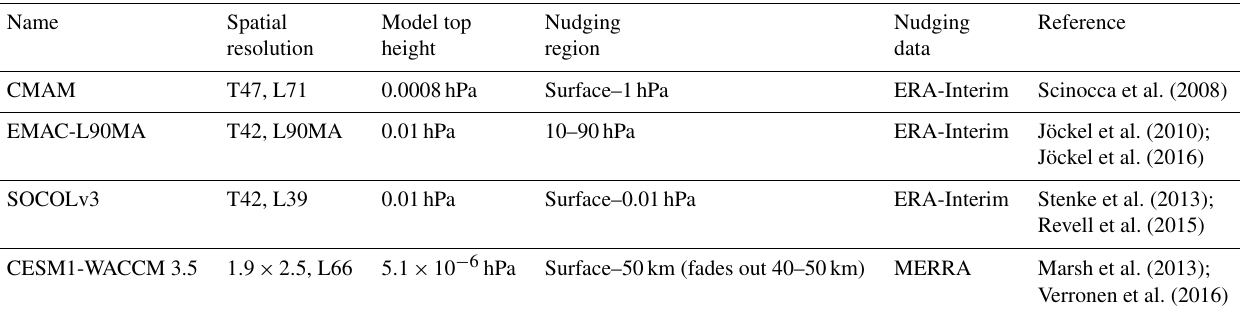
Table 1. CCMI-1 model